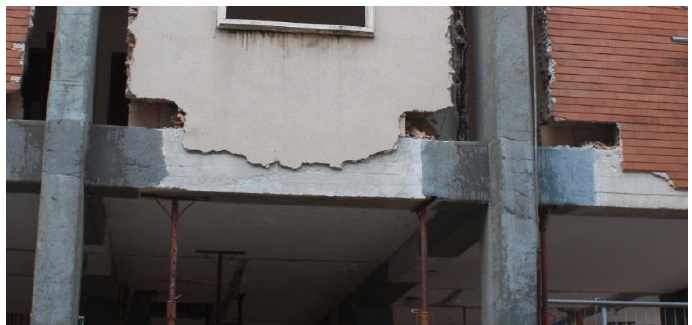
Figure 7. SRP strengthened the frame of a multistory building.